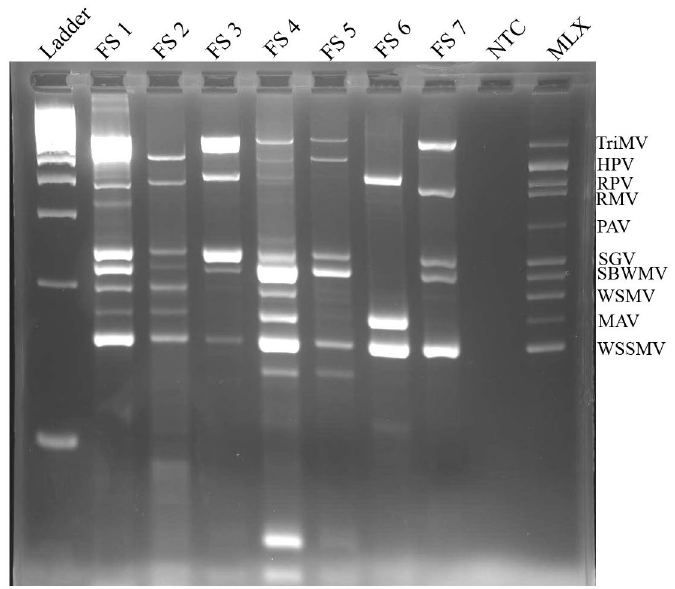
Figure 1. Multiplex RT-PCR with 10 wheat viruses. Lanes 2–11 show individual PCRs amplifying the two newly added viruses TriMV (Lane 10) and HPV (Lane 11) in addition to the YDV strains PAV, RPV, MAV, RMV, SGV (Lanes 2–6) and other wheat viruses WSSMV, SBWMV, and WSMV (Lanes 7–9) with a no template control (Lane 12). The M-RT-PCR identifying all these ten viruses in a multiplex (Lane 14) shows these added viruses as two new gel bands on the top in comparison to the previously developed multiplex PCR with eight viruses (Lane 13). Lanes 1 and 14 have 100 bp molecular marker as a reference.